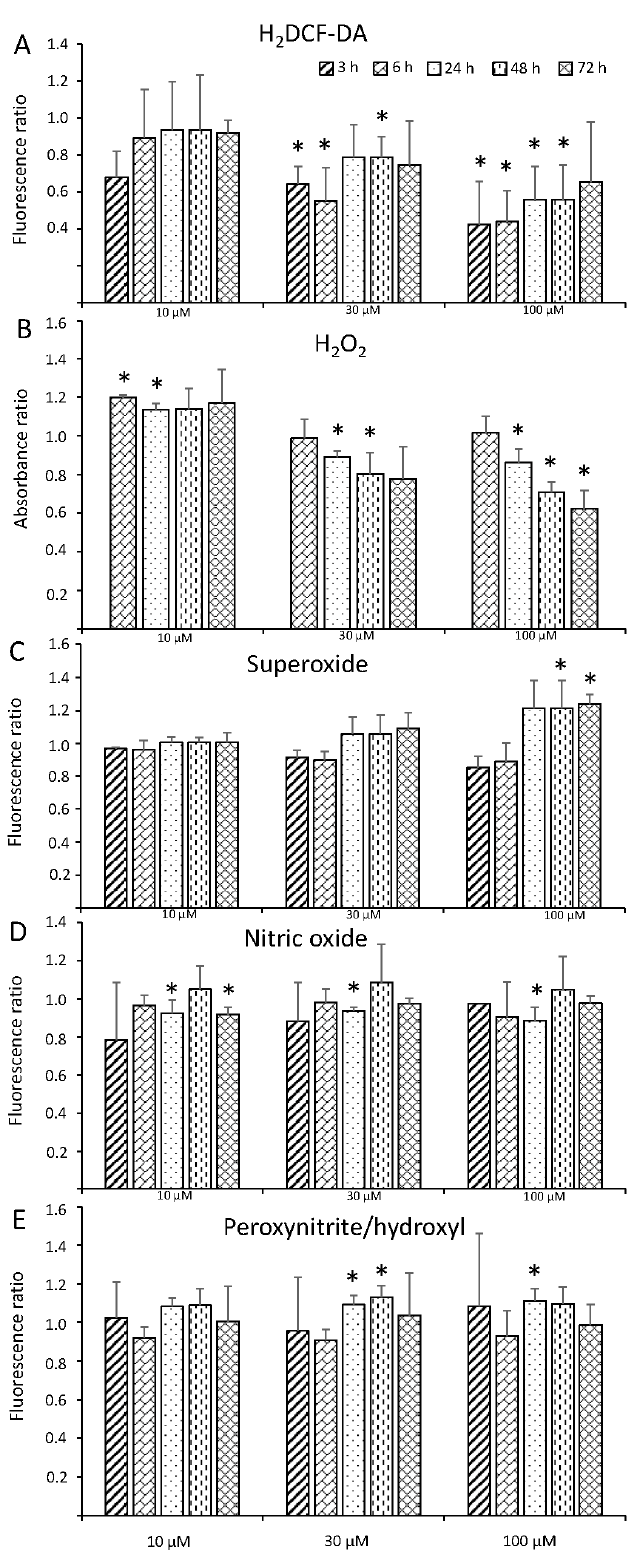
Figure 2. Intracellular oxidating events, as measured by H 2 DCF-DA fluorescence ( A ), extracellular H 2 O 2 ( B ), O 2 − ( C ), NO ( D ), and ONOO − / · OH ( E ) levels of cultures treated with 10, 30, and 100 µ M HgCl 2 for 3 h, 6 h, 24 h, 48 h, and 72 h, relative to the corresponding control values. N = 4 ± SD. Asterisks indicate significant di ff erences compared to the corresponding control value, for p <